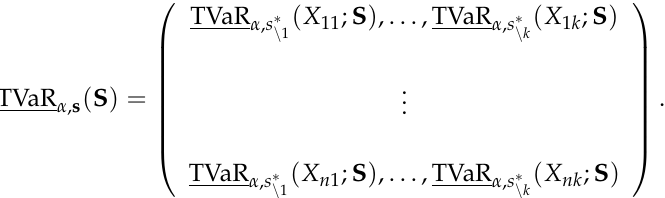
Figure 1. Analytic solution and approximation of TVaR 0.99, s